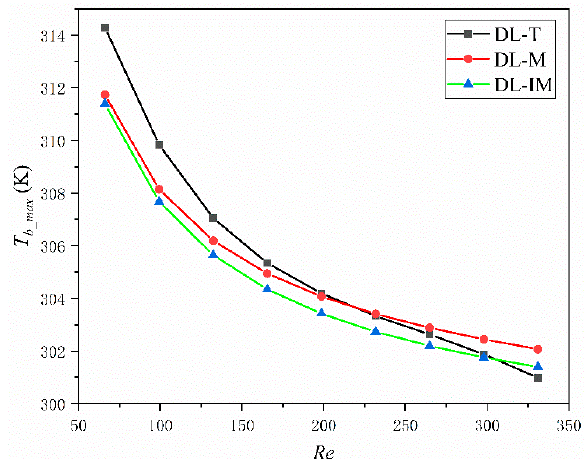
Figure 8. Maximum temperature on the base surface of DL-T, DL-M and DL-IM structure in different Reynolds number conditions.